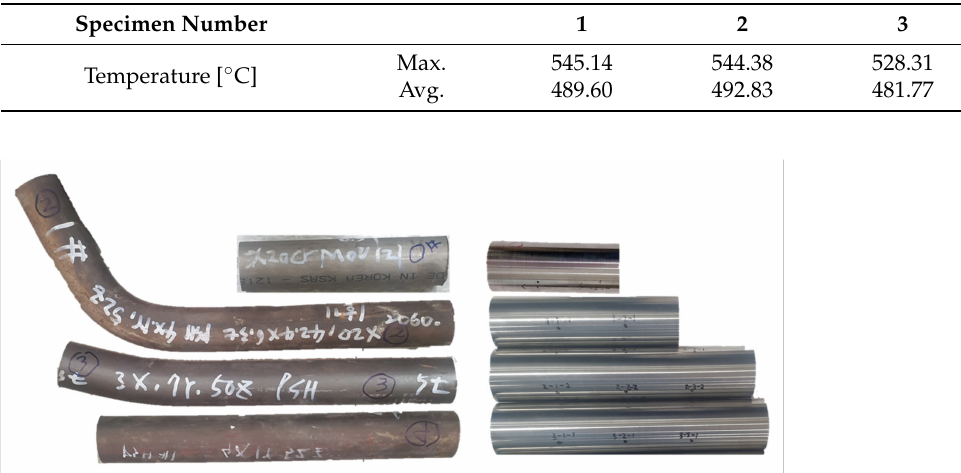
Figure 3. Boiler tube original samples ( left ) and after processing for ultrasonic measurement ( right ).